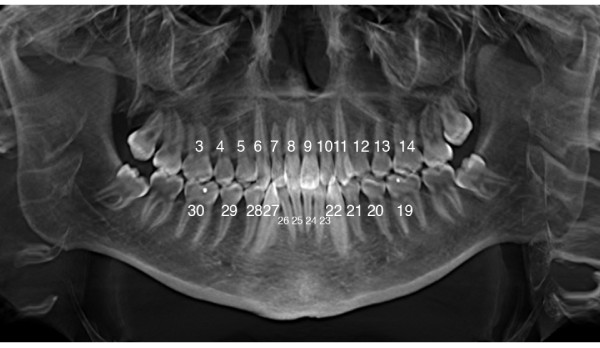
Notation of Teeth.